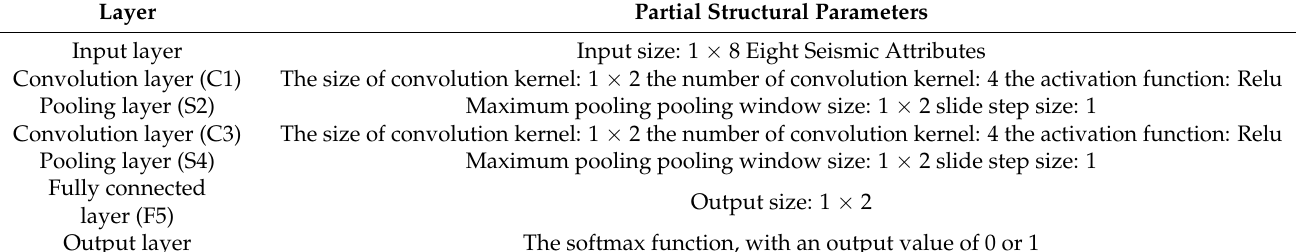
Table 6. Structural parameters of Model 3.